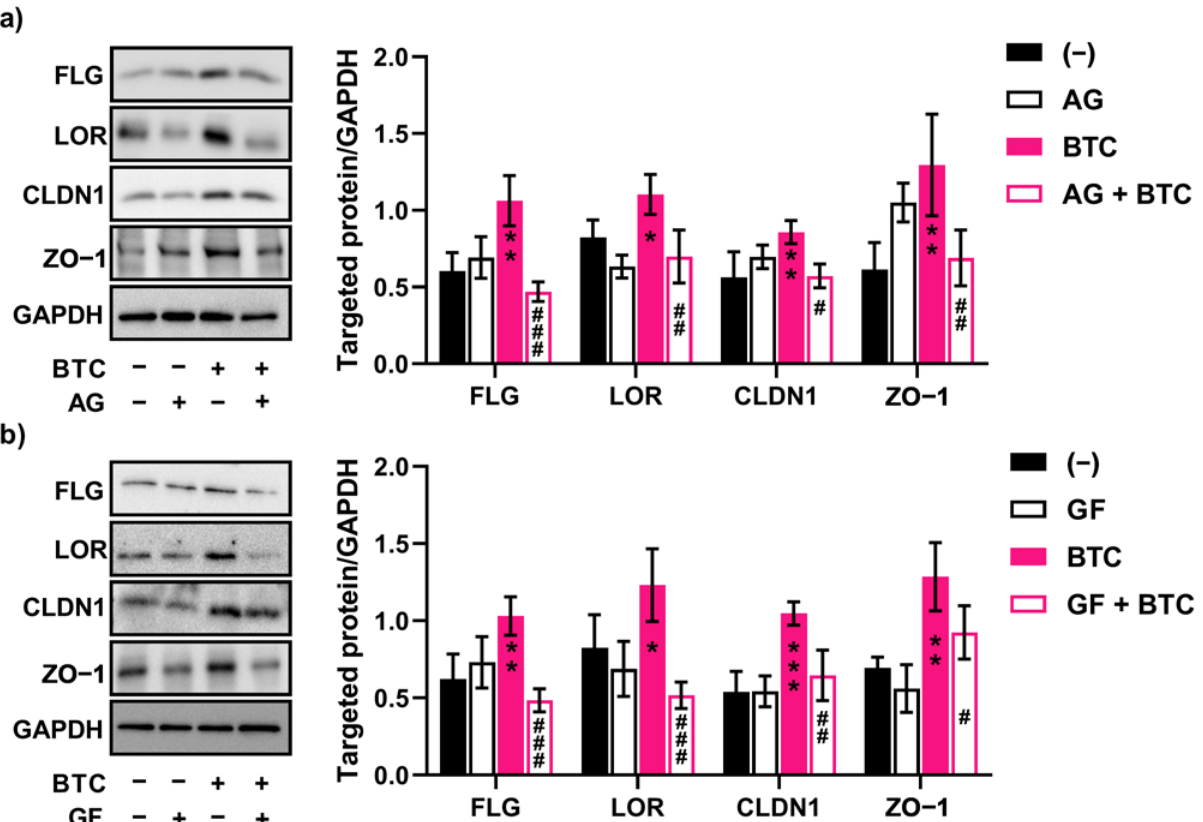
Figure 6. BTC regulates the skin barrier function through the EGFR and PKC signaling pathways. Cells were pretreated with AG-1478 (AG) ( a ) or GF109203X (GF) ( b ) for 2 h and then treated with 100 ng/mL BTC for 24 h. Representative immunoblots of the indicated proteins are shown. The quantification of the band intensities is shown in the right panels, n = 4/group. * p < 0.05, ** p < 0.01, and *** p < 0.001 versus the control group; # p < 0.05, ## p < 0.01, and ### p < 0.001 versus the BTC-treated group.